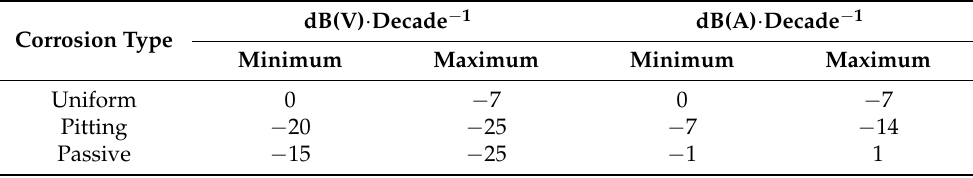
Table 3. Intervals of β values of PSD to determine corrosion type.